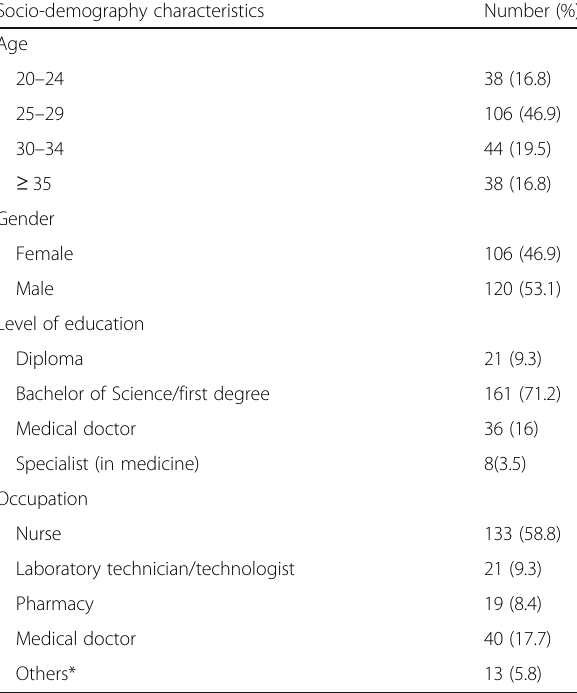
Table 1 Socio-demographic characteristics of health